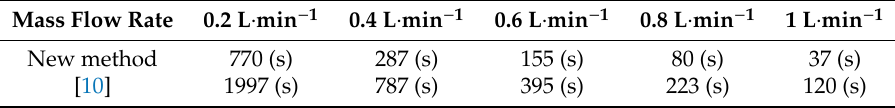
Table 2. The computation time of numerical models during a